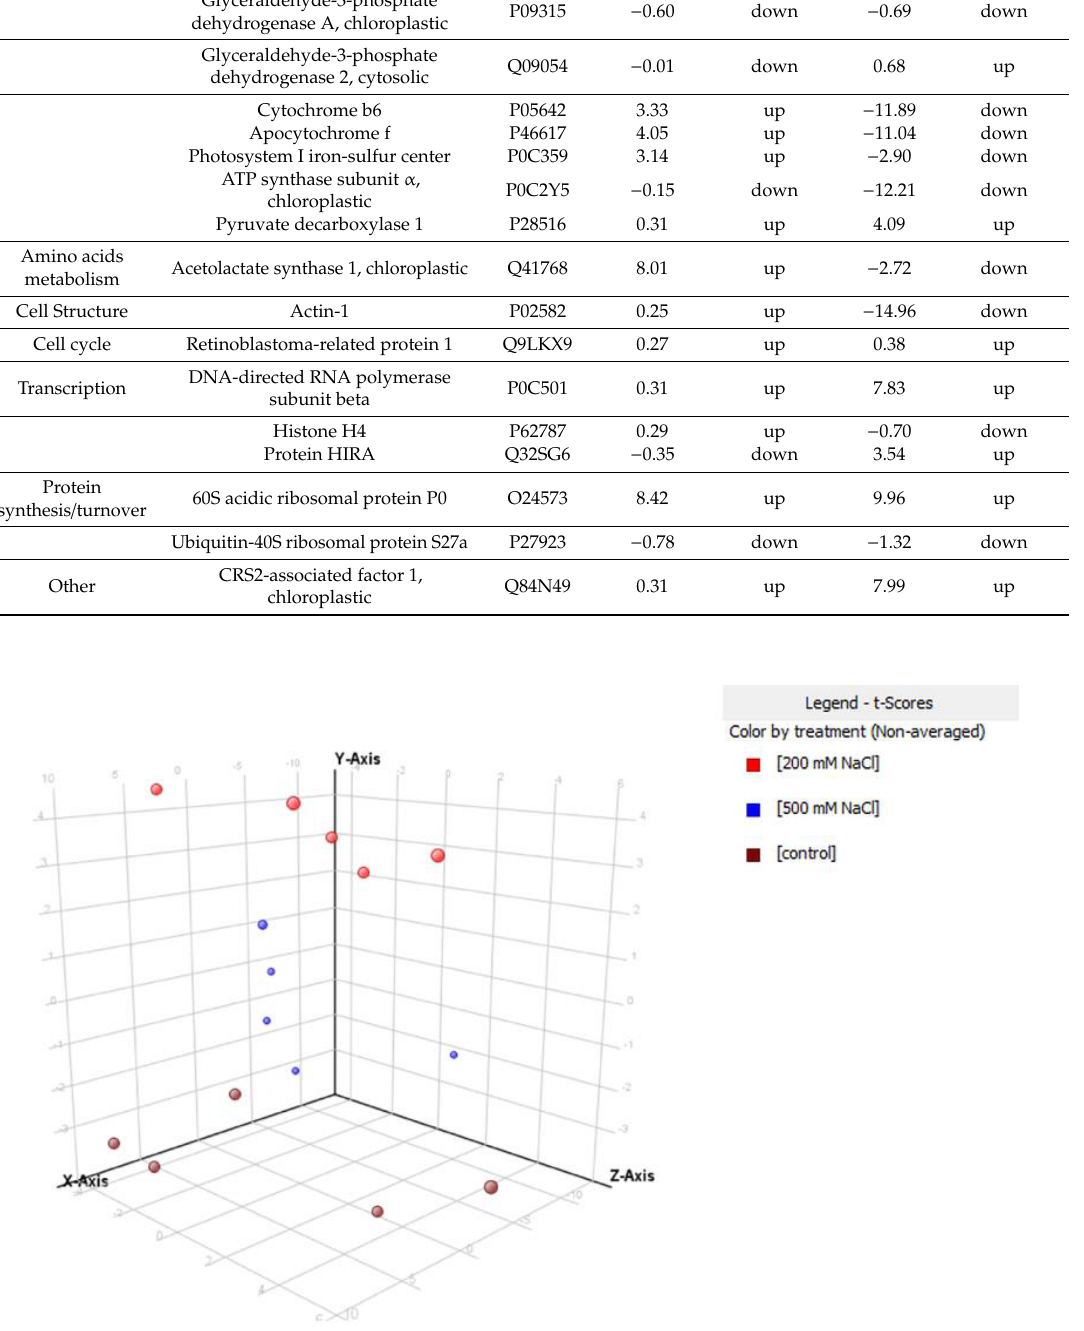
Figure 3. Partial least squares discriminant analysis (PLS-DA) on Suaeda maritima according to their protein response to 200 mM NaCl and 500 mM NaCl. Individual replications are given in the class prediction model score plot.